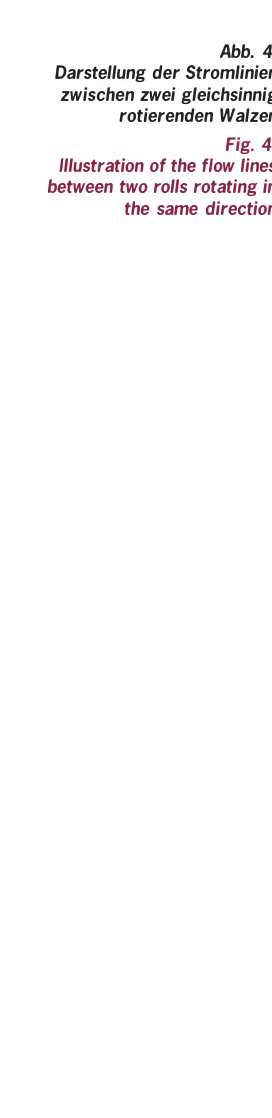
Fig. 4: Illustration of the flow